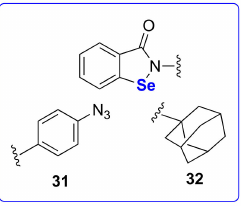
Figure 6. Structures of Mtb Ag85C